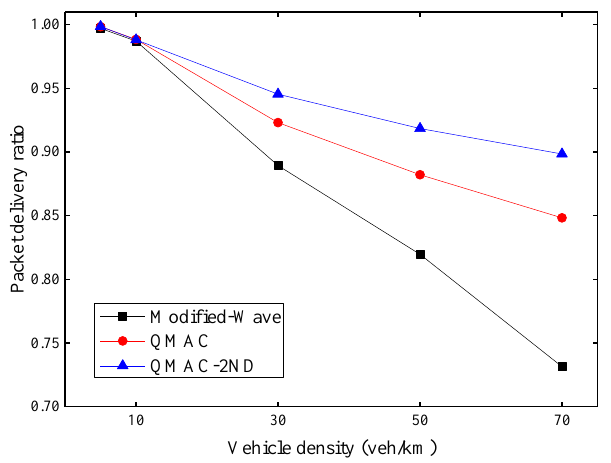
Figure 9. Average packet delivery ratio under different vehicle densities.